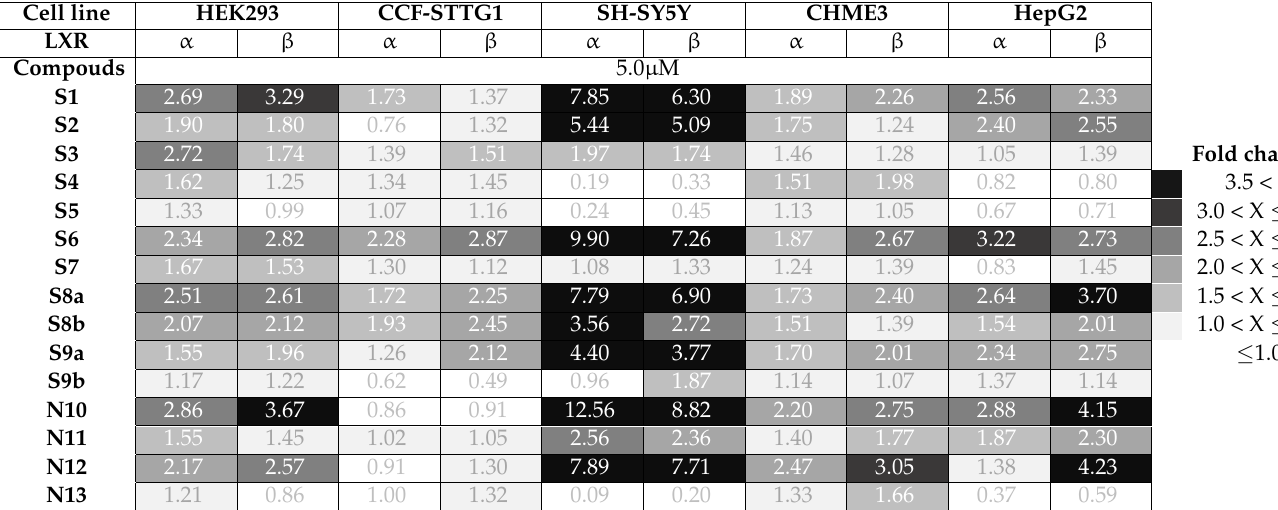
Table 1. LXR α and β transcriptional activities of side-chain oxysterols in different cell